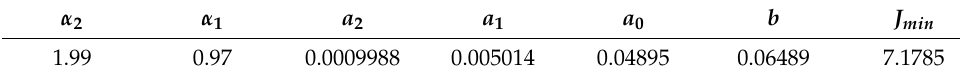
Table 2. Parameter identification results of the fractional-order system.